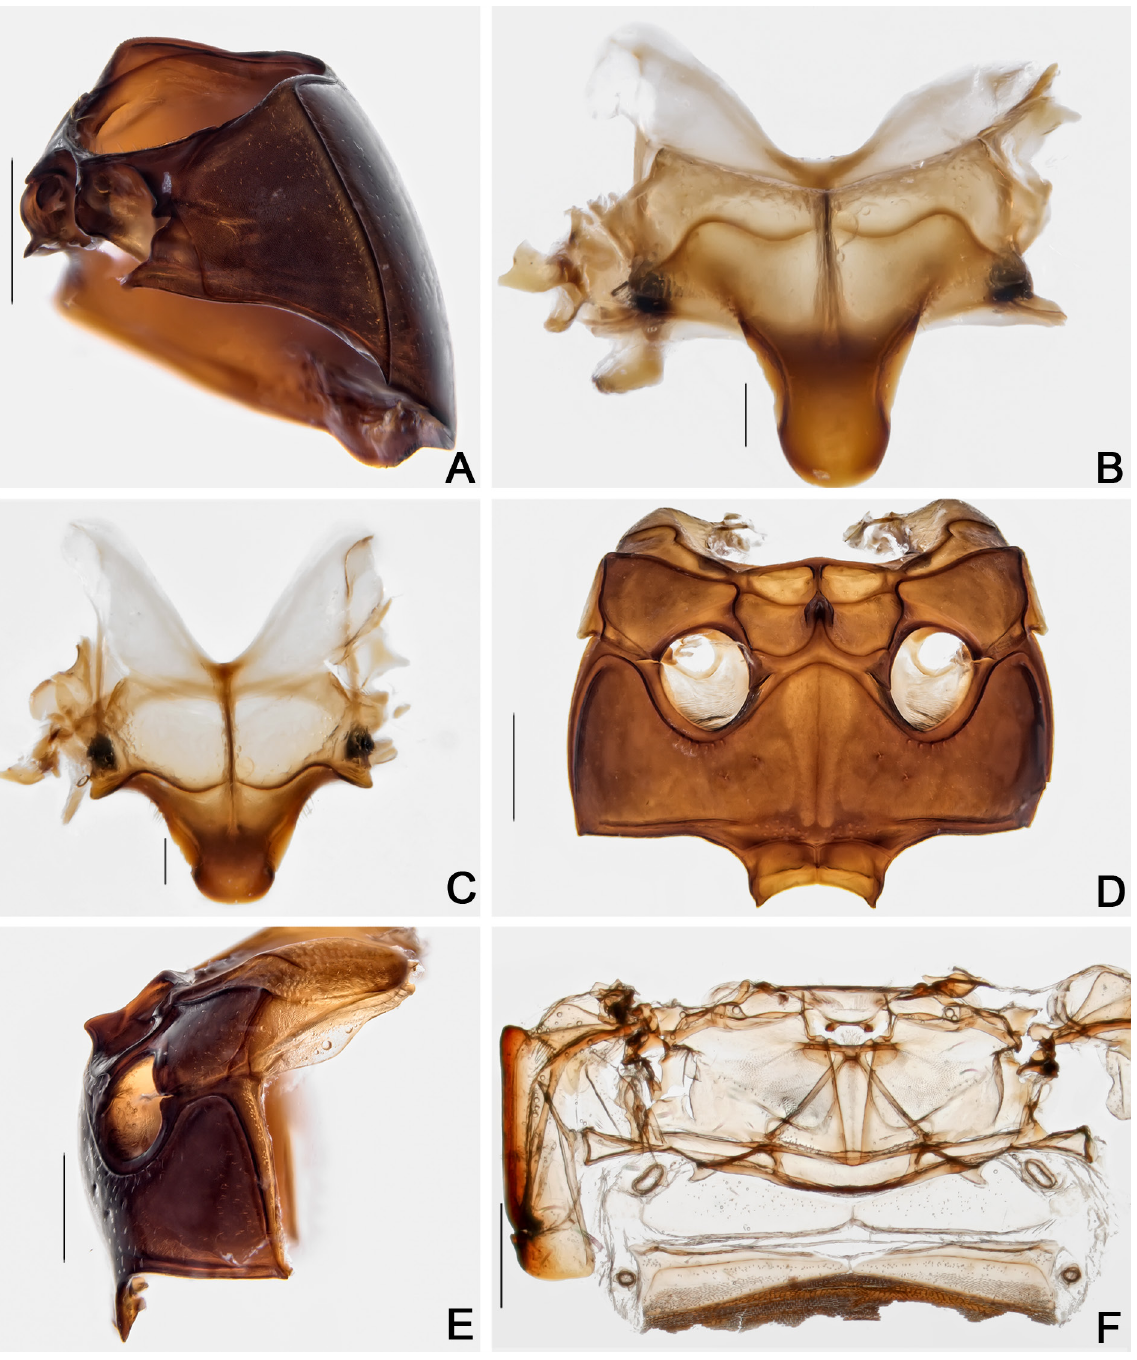
Fig. 41. Cyparium pici sp. nov., paratype, ♂ (CELC). A . Prothorax, lateral view. B–C . Scutellar plate. B . Dorsal view. C . Apically slanted view. D–E . Meso- and metathorax. D . Ventral view. E . Lateral view. F . Metanotum. Specimen collected at Cotriguaçu (MT, Brazil). Scale bars: A, D–F = 0.5 mm; B–C = 0.1